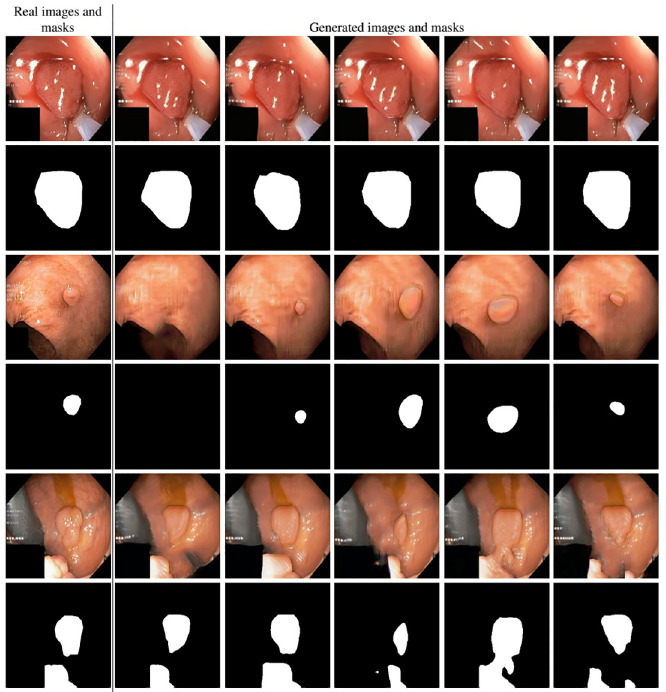
Fig 4. Real vs. synthetic data. Samples of real images and corresponding SinGAN-Seg generated synthetic GI-tract images with corresponding masks. The first column contains real images and masks. All other columns represent randomly generated synthetic data from our SinGAN-Seg models, which were trained using the image in the first column.